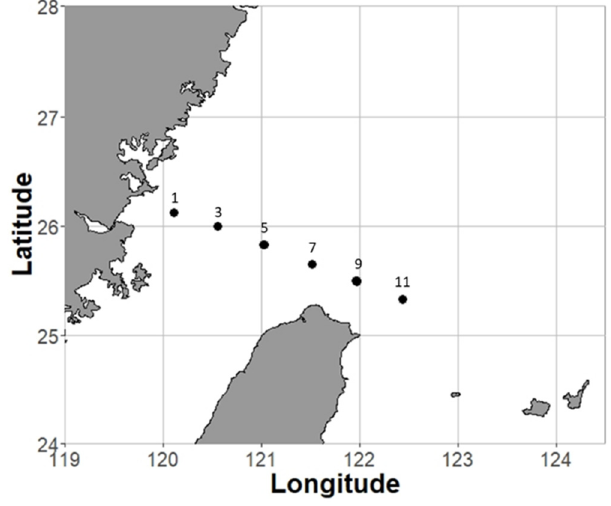
Figure 1. Sampling area and sites (1, 3, 5, 7, 9, 11) in the southern East China Sea.